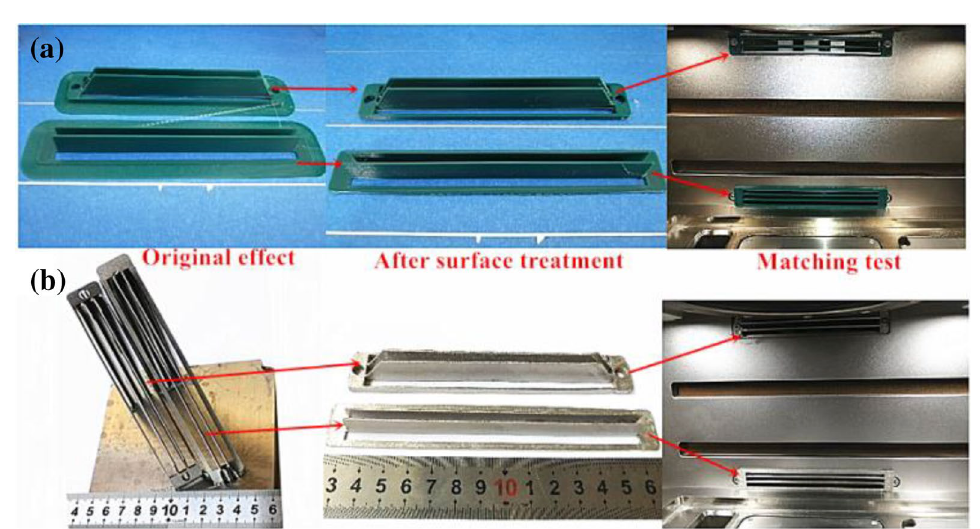
Figure 10. Effect and matching test results of 3D printed curved deflector: ( a ) FDM technology molding; ( b ) SLM technology